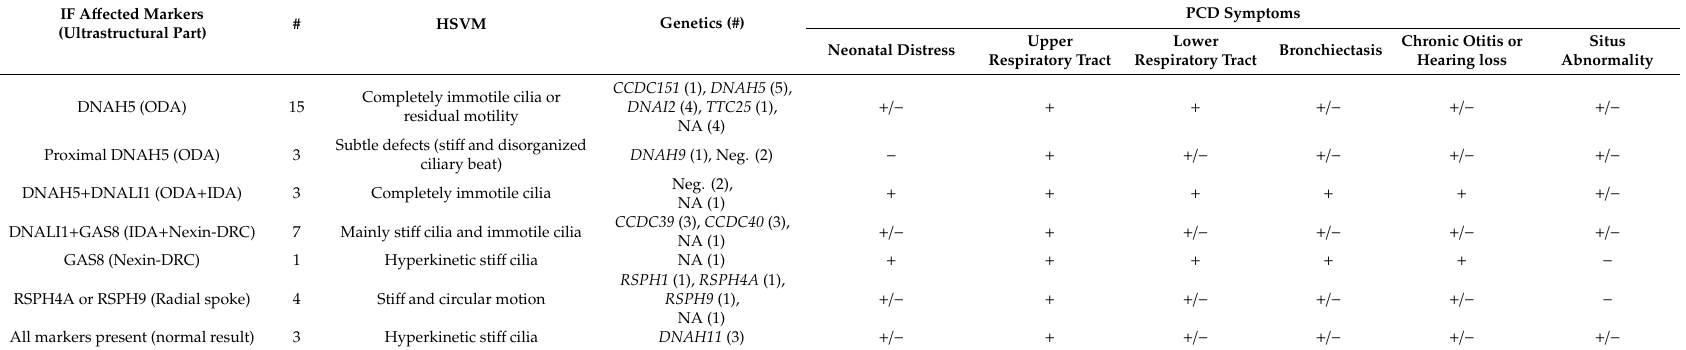
Table 2. Correlation among immunofluorescence analysis, high-speed video-microscopy, genetics and clinical characteristics in our PCD patients. IF A ff ected Markers (Ultrastructural